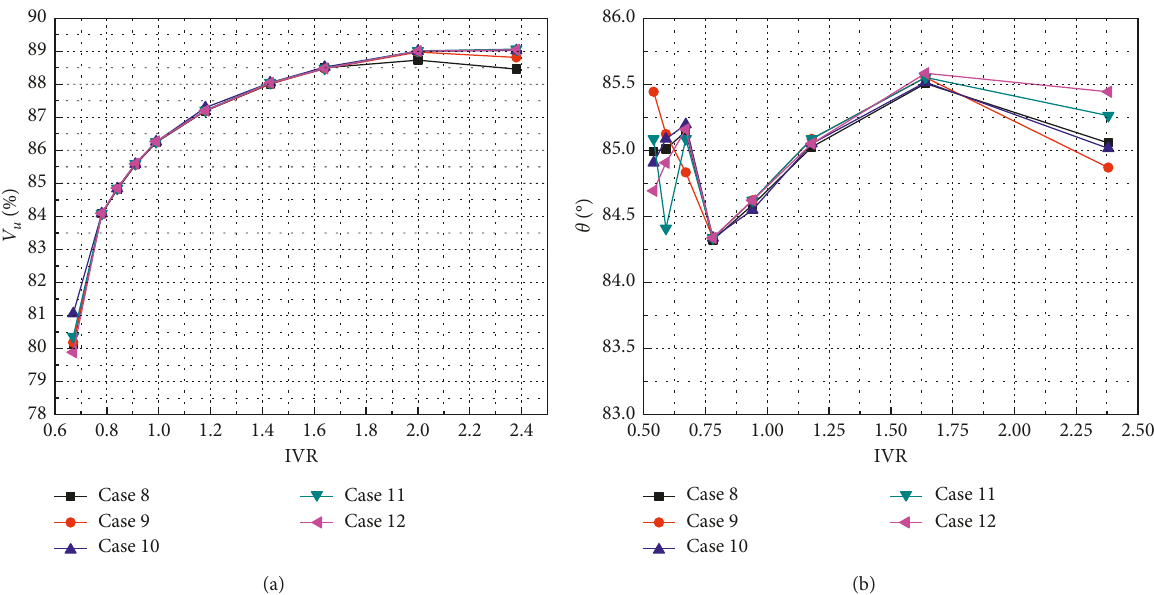
Figure 26: Hydraulic characteristics of inlet passage outlet with different lip structures. (a) Axial velocity distribution coefficient V Weighted-velocity average swirl angle θ .